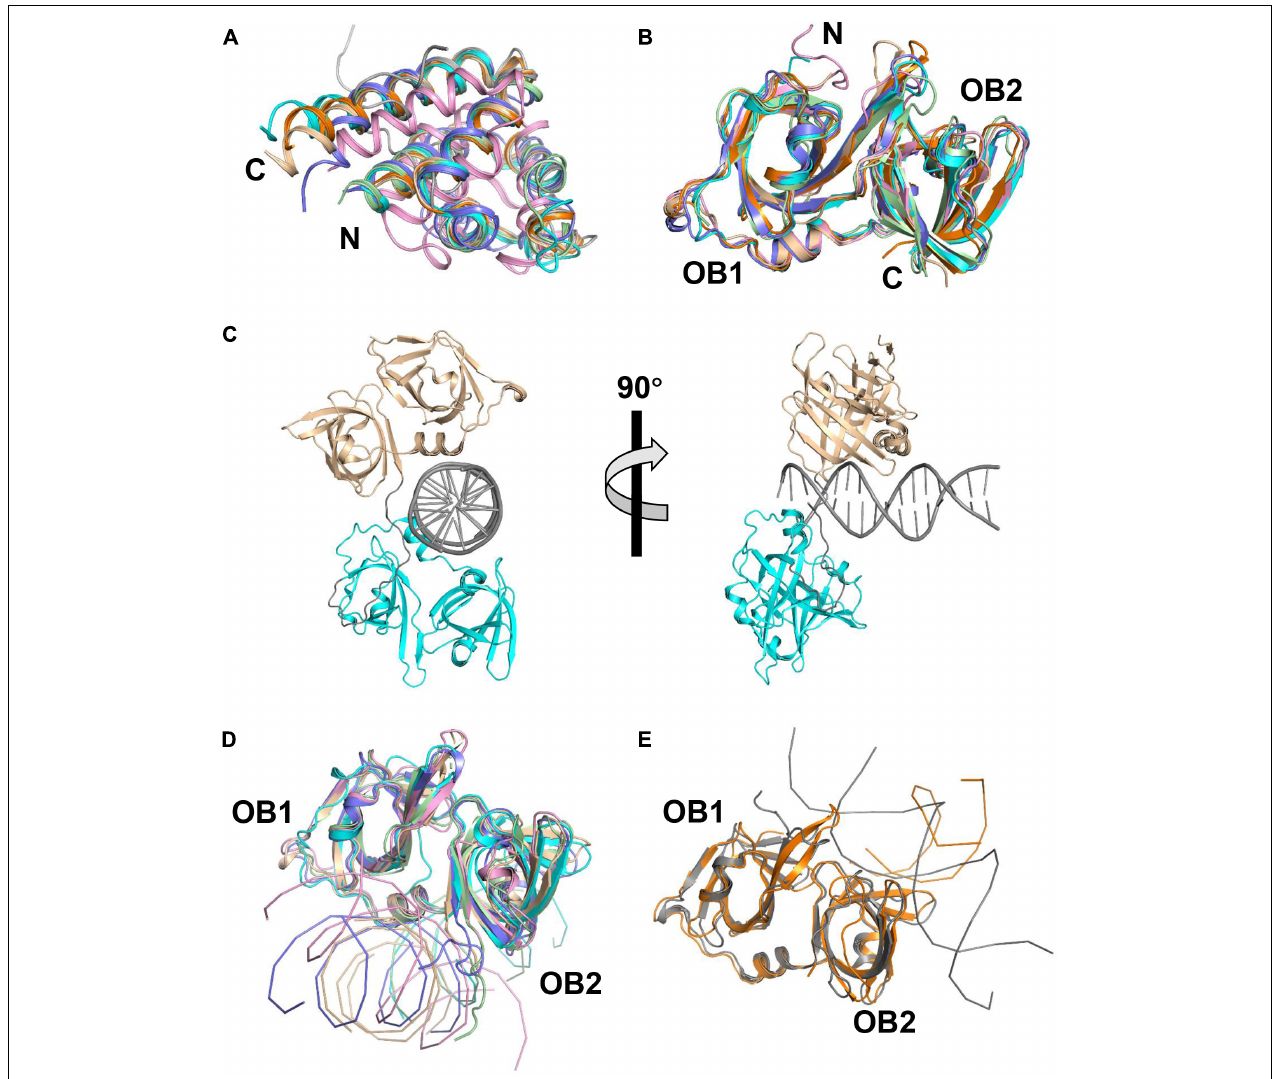
FIGURE 2 | Structures of PYHIN family proteins. (A) Structural superposition of PYD of AIM2, MNDA, and p205. The structure of human AIM2 PYD with MBP (PDB: 3VD8) and its mutant (F27G, PDB: 4O7Q) are shown in cyan and pale green. The structure of mouse AIM2 PYD (PDB: 2N00) is shown in slate. Structures of human MNDA PYD without MBP (PDB: 5WPZ) and with MBP (PDB: 5H7Q, 5WQ6) are shown in pink, orange, and wheat. The solution structure of p205 PYD (PDB: 2YU0) is shown in gray. (B) Structural superposition of HIN domains of IFI16, p202, and p204. Structures of p204 HINa (PDB: 5YZP) and HINb (PDB: 5YZW) are shown in wheat and cyan. Structures of IFI16 HINa (PDB: 2OQ0) and HINb (PDB: 3B6Y) are shown in orange and slate. Structures of p202 HINa (PDB: 4JBJ) and HINb (PDB: 4L5T) are shown in pink and pale green. (C) Crystal structure of p204 HINab: dsDNA complex. Structures of p204 HINa and HINb are shown in wheat and cyan. dsDNA and the linker between HINa and HINb are shown in gray. (D) Similar DNA-binding mode of AIM2, IFI16 HINb, and p204 HINa and HINb. Structures of p204 HINa: DNA (wheat) and HINb: DNA (cyan) are from HINab: dsDNA complex (PDB: 5Z7D). Structures of human AIM2 HIN (PDB: 3RN2), mouse AIM2 HIN (PDB: 4JBM), and IFI16 HINb (PDB: 3RNU) are shown in pink, pale green, and slate, respectively. (E) Similar DNA-binding mode of IFI16 HINa and p202 HINa. Structures of p202 HINa (PDB: 4L5R) and IFI16 HINa (PDB: 4QGU) are shown in gray and orange,